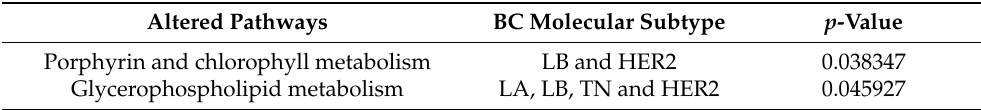
Table 3. Altered pathways associated with BC molecular subtypes by ESI+ and ESI − . Altered